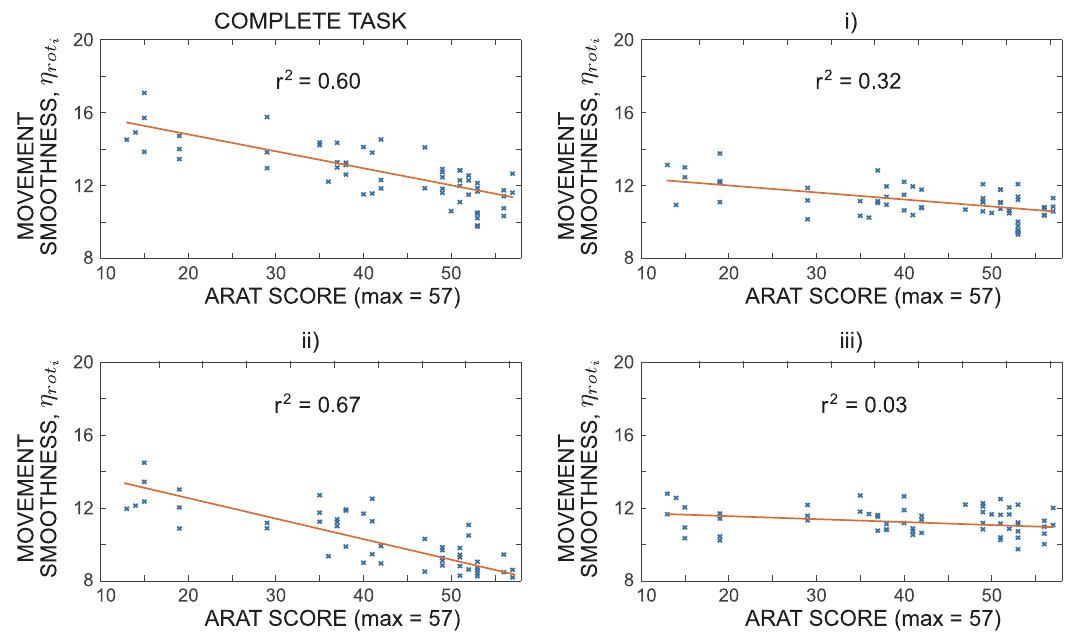
Figure 8. Relation between ARAT score and movement smoothness represented as patient’s affected arm rotational jerk index η rot computed for the grip subtest and its three phases. i